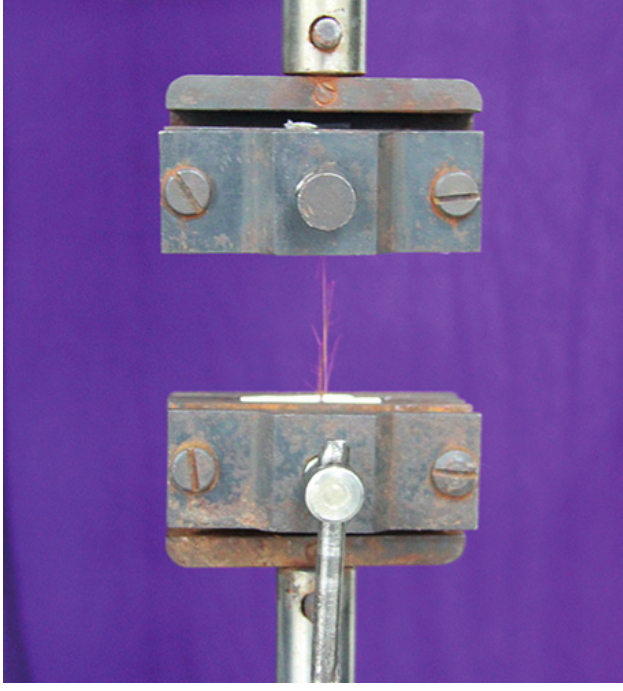
Figure 2. Fracture profile of a bamboo